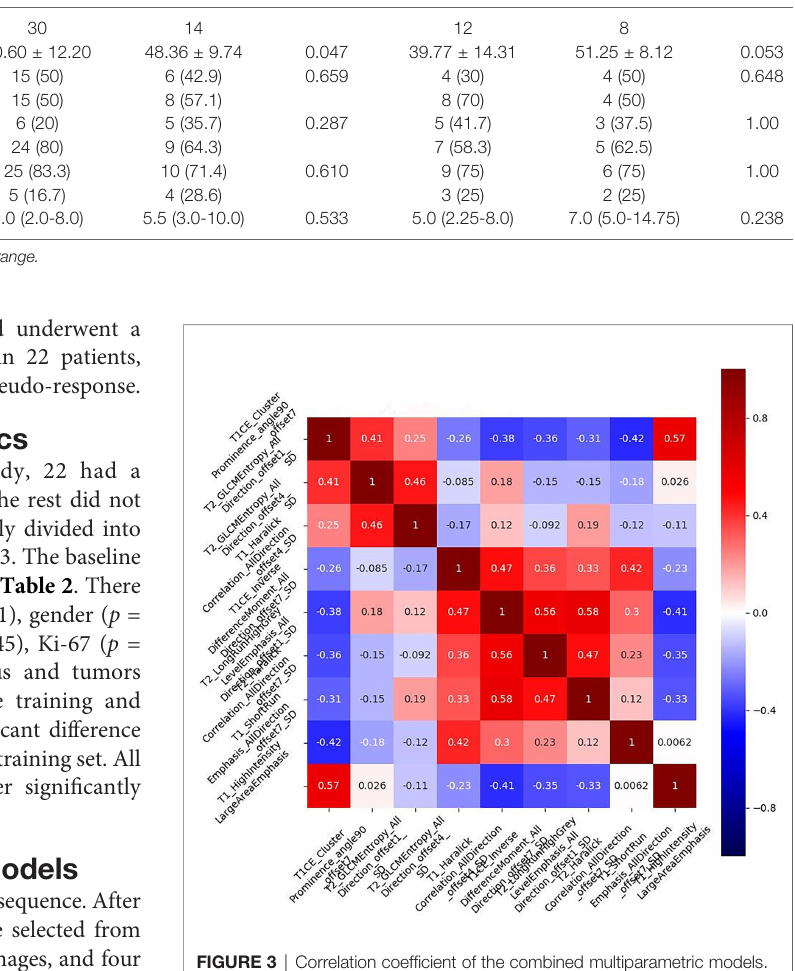
FIGURE 3 | Correlation coef fi cient of the combined multiparametric models. The correlation coef fi cients of the selected nine features were low, indicating that the nine feature clusters were not redundant. The magnitude of the correlation is illustrated in the color bar on the